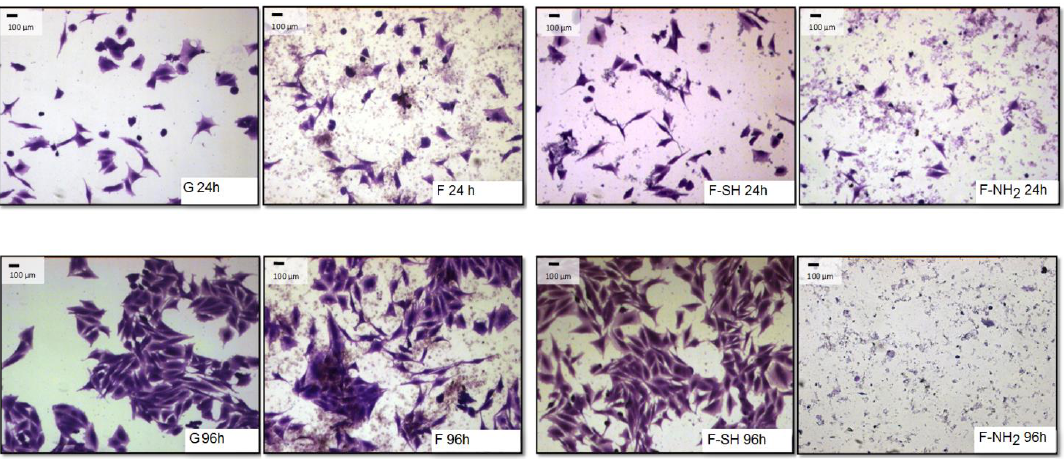
Figure 8. Paraformaldehyde (PFA) fixed and Coomassie Blue-stained Saos-2 cells grown for 24 and 96 h on the different substrates.